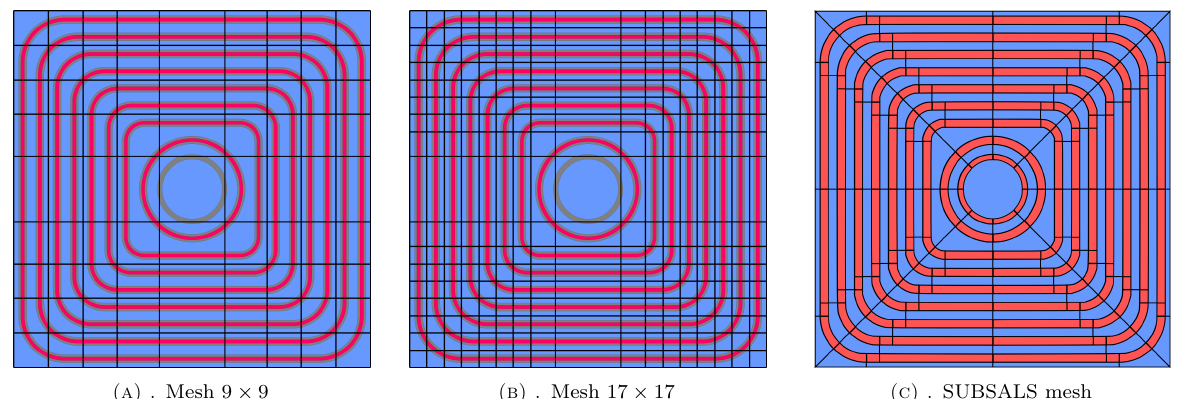
Figure 1. Cartesian mesh detectors 9 × 9 and 17 × 17, and SUBSALS thermal-hydraulic model for 8-tube IRT-4M fuel